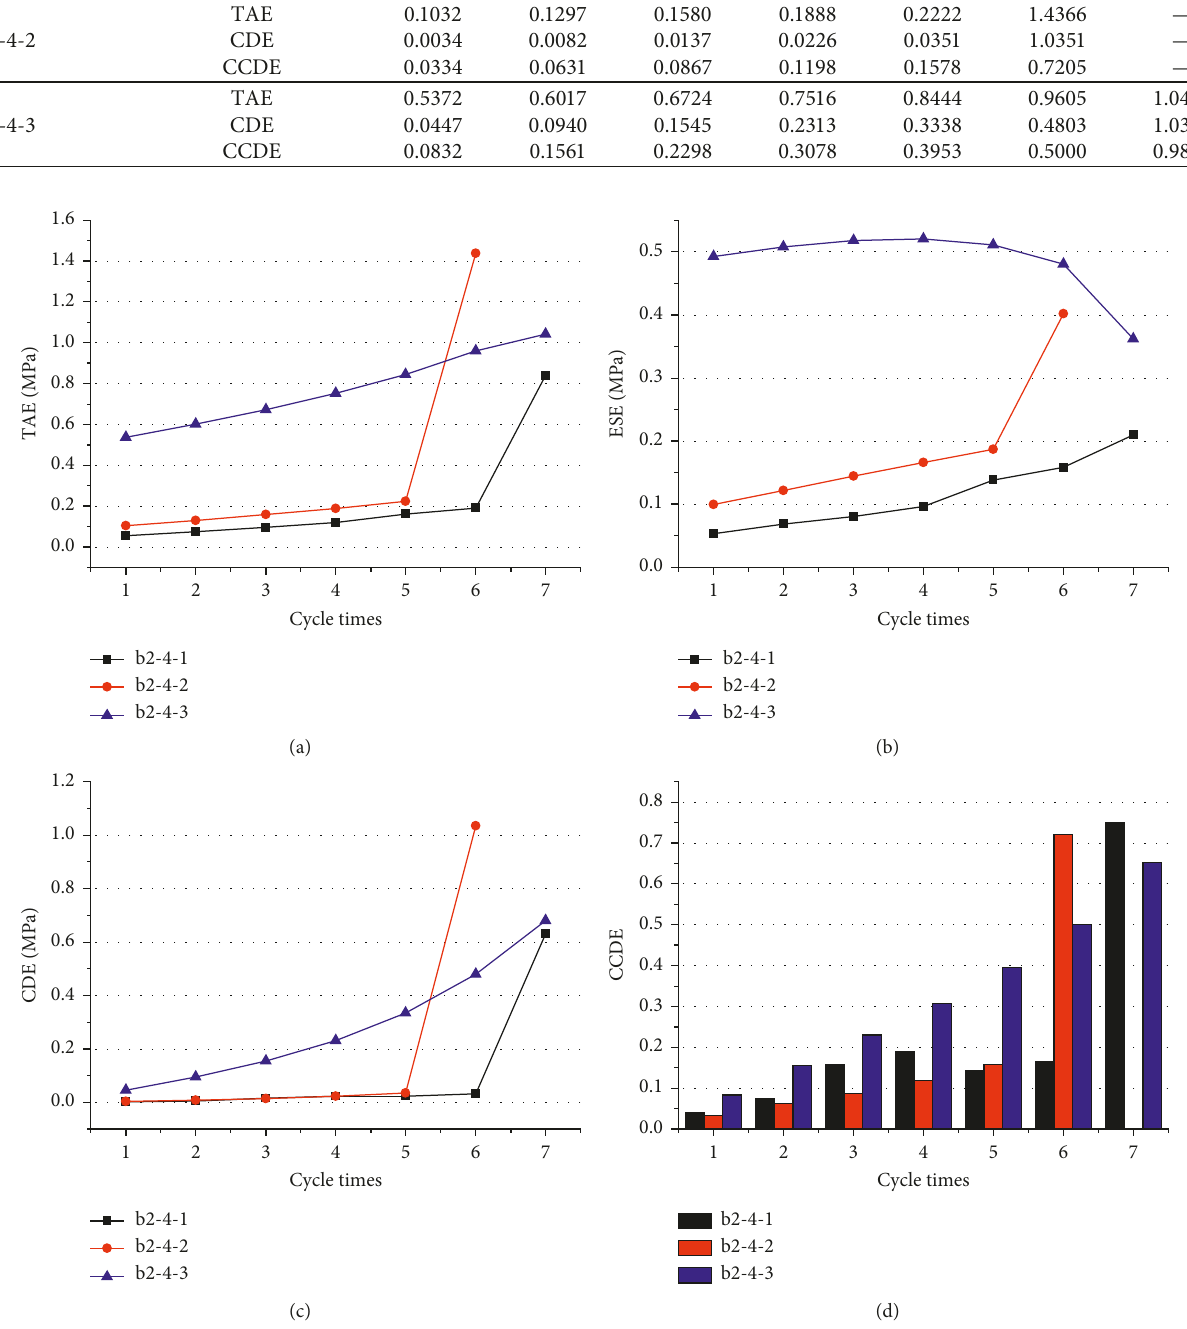
Figure 10: Relation curves of energy parameters and cycle times under cyclic loading-unloading: (a) TAE; (b) ESE; (c) CDE; (d) CCDE.